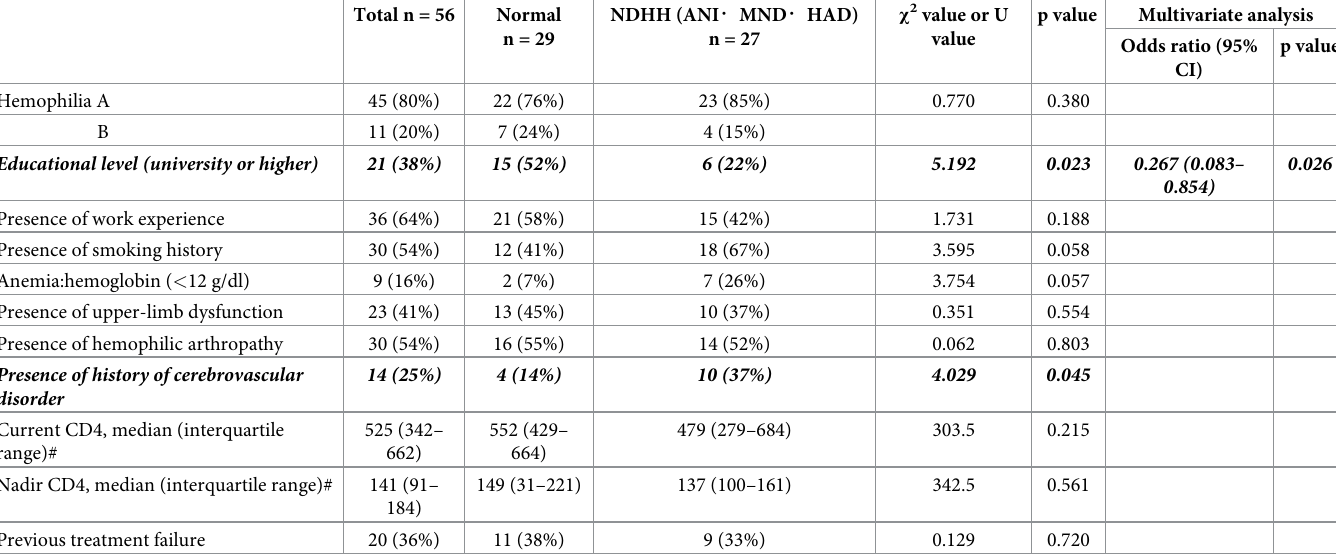
Table 3. Associated factors in the NDHH